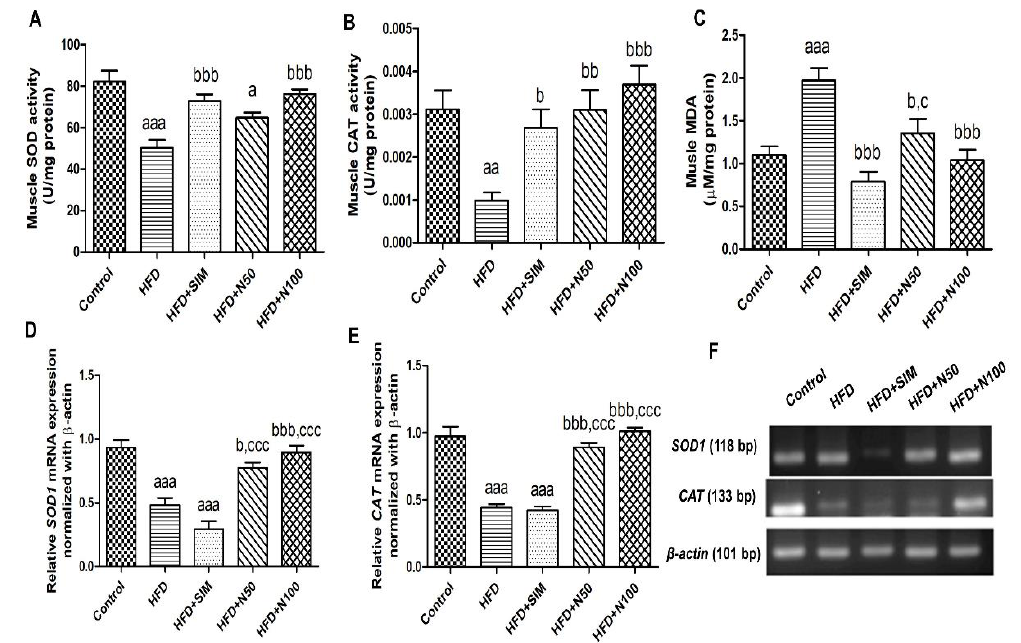
Figure 4. The effect of naringin on antioxidant activity and lipid peroxidation in high-fat-diet-fed rats. SOD ( A ), CAT ( B ), and MDA ( C ) of muscle tissue in rats. The mRNA expression of SOD1 ( D ) and CAT ( E ) in the quadriceps muscle tissues of the rats. ( F ) Representative mRNA expression images of antioxidant enzymes in the quadriceps tissues. Results are shown as mean ± SEM for 6 rats per group. a p < 0.05, aa p < 0.01, and aaa p < 0.001 vs. the control group; b p < 0.05, bb p < 0.01, and bbb p < 0.001 vs. the HFD group; c p < 0.05, and ccc p < 0.001 vs. the HFD + SIM group.